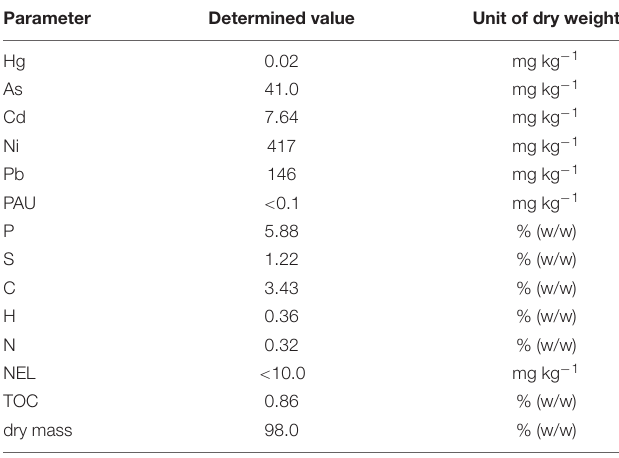
TABLE 1 | Input values of ash from the sludge